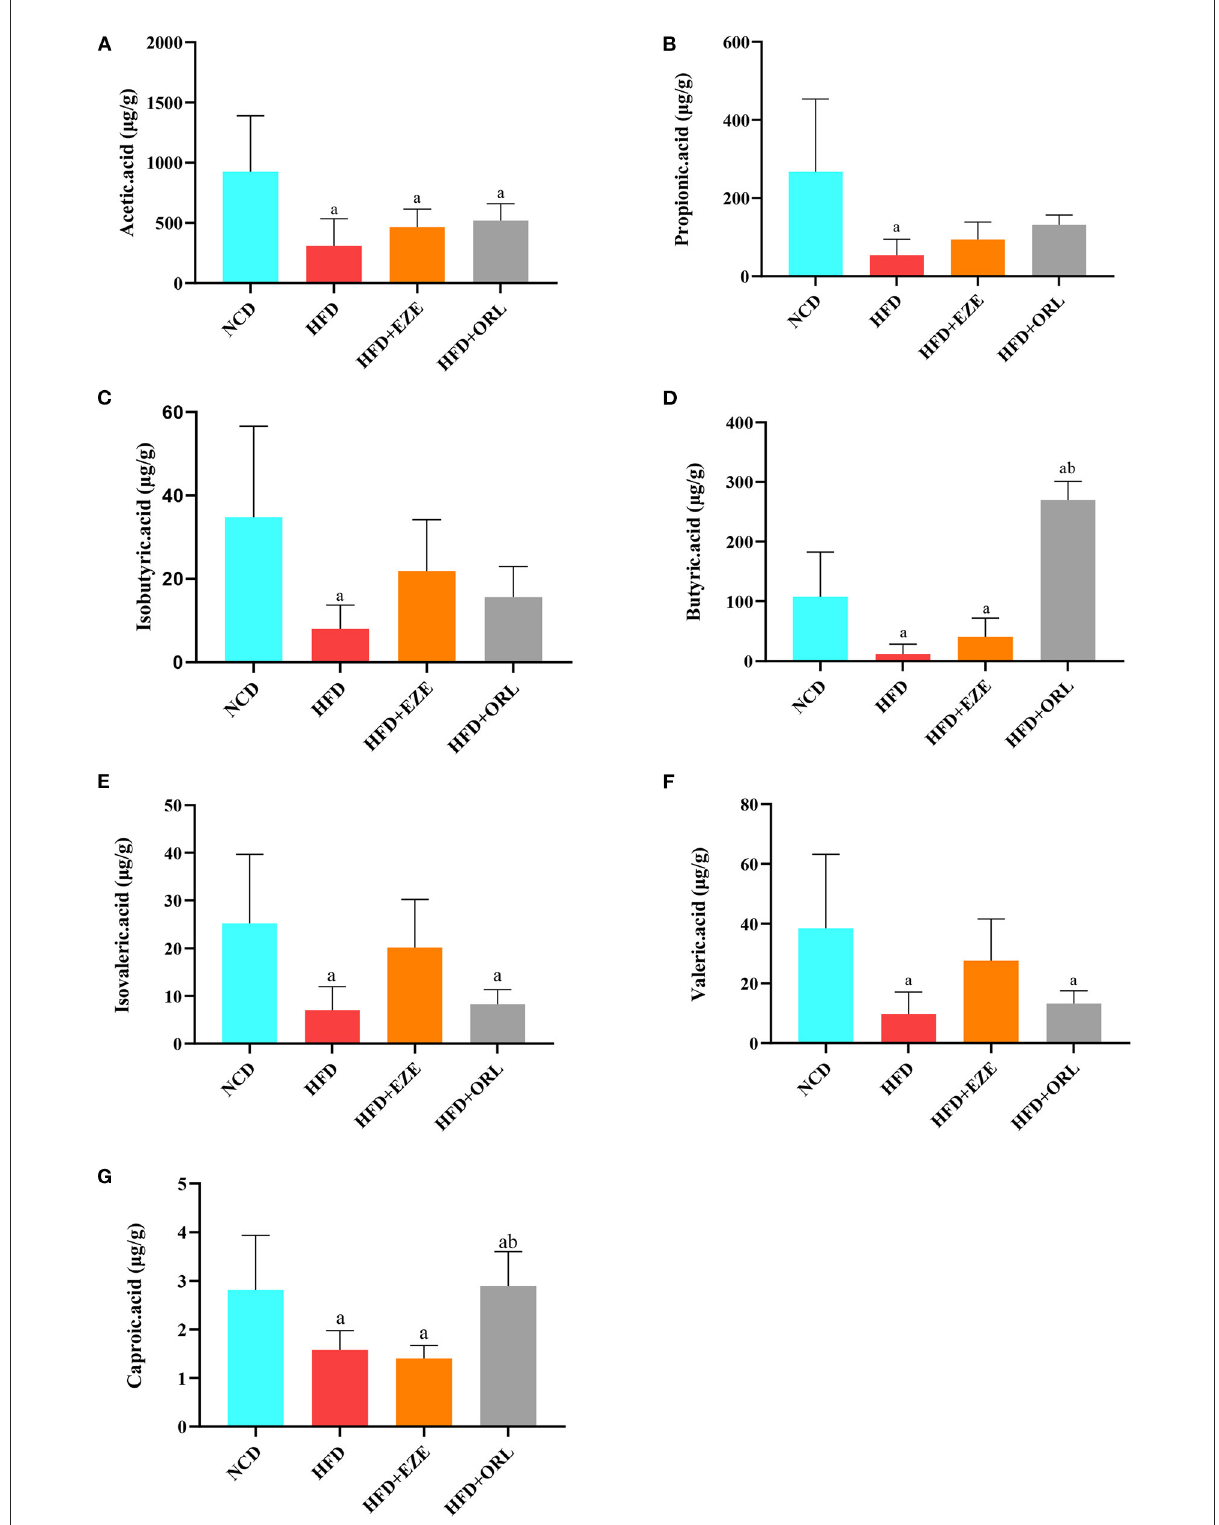
FIGURE4 Fecal short-chain fat acid (SCFA) levels of mice in different groups ( µ g/g wet weight of feces). (A) Acetic acid levels in fecal samples. (B) Propionic acid levels in fecal samples. (C) Fecal isobutyric acid levels. (D) Fecal butyric acid levels. (E) Fecal isovaleric acid levels. (F) Fecal valeric acid levels. (G) Fecal caproic acid levels. a: P < 0.05 compared with the NCD group. b: P < 0.05 compared with the HFD group. NCD, normal diet; HFD, high-fat diet; HFD + EZE: high-fat diet and intervention of ezetimibe; HFD + ORL: high-fat diet and intervention of orlistat; n = 6 per